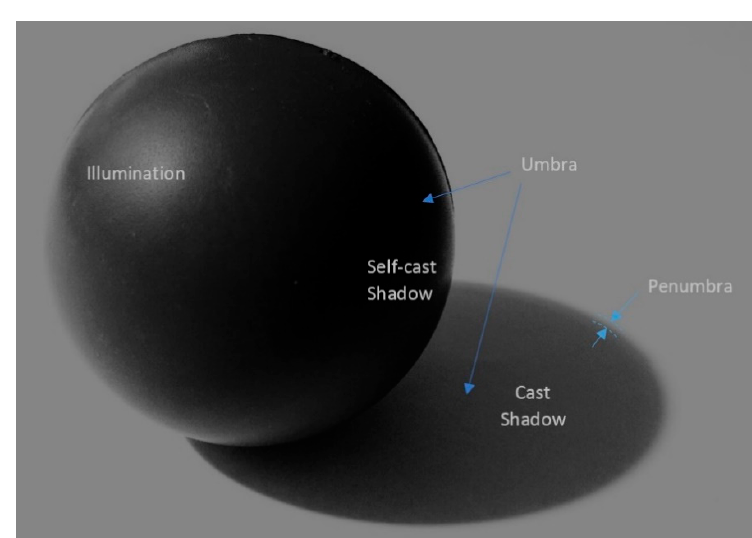
Figure 1. Shadow definitions adopted from Arévalo, et al. [3].